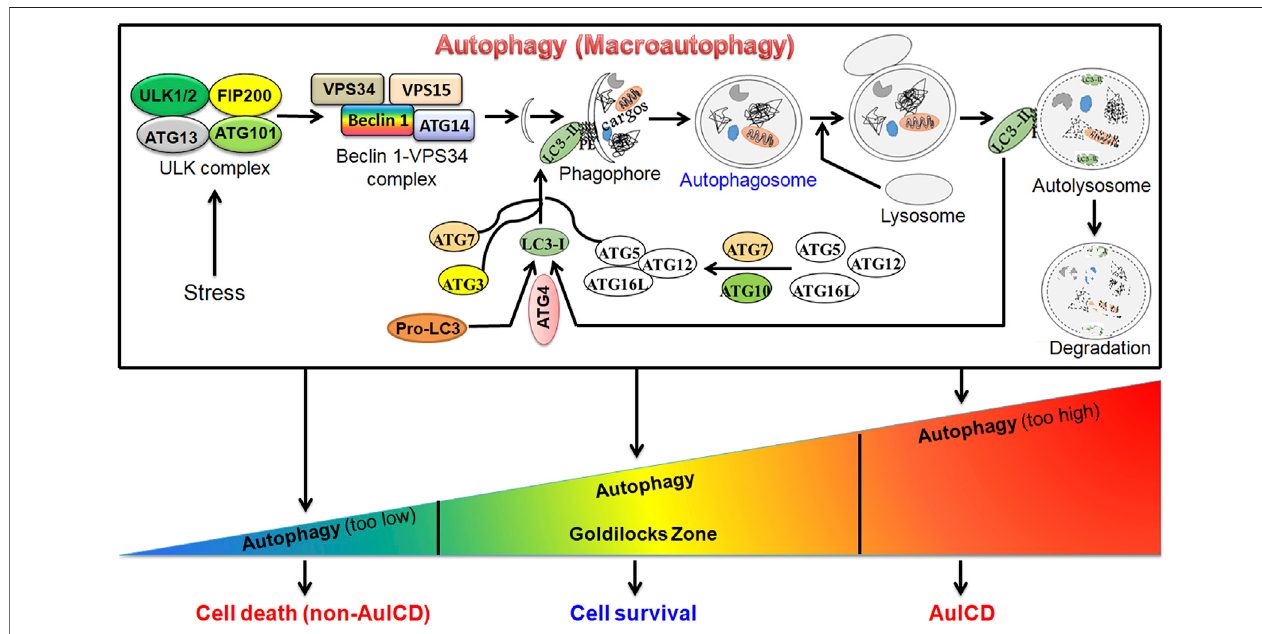
FIGURE 1 | A graphic model for the canonical autophagy pathway and roles of autophagy in cell survival and death. Under stress (e.g., starvation), autophagy is induced.This isfollowedbytheformationofautophagosome, adouble-membrane vesicle, which fuseswiththelysosometoformautolysosometodegrade cargo(s) by lysosomal enzymes. Autophagy can be at different levels. In the homeostatic “ Goldilocks Zone ” condition, autophagy promotes cell survival and prevents cell death. When it is deregulated, cell death can be induced via two mechanisms. First, when autophagy is highly downregulated, the accumulation of damaged cellular organelles, such as dysfunctional mitochondria, or other components triggers cell death. Second, when autophagy is highly upregulated, it degrades essential cellular compoents or organelles such as mitochondria leading to autophagy-induced cell death (AuICD).